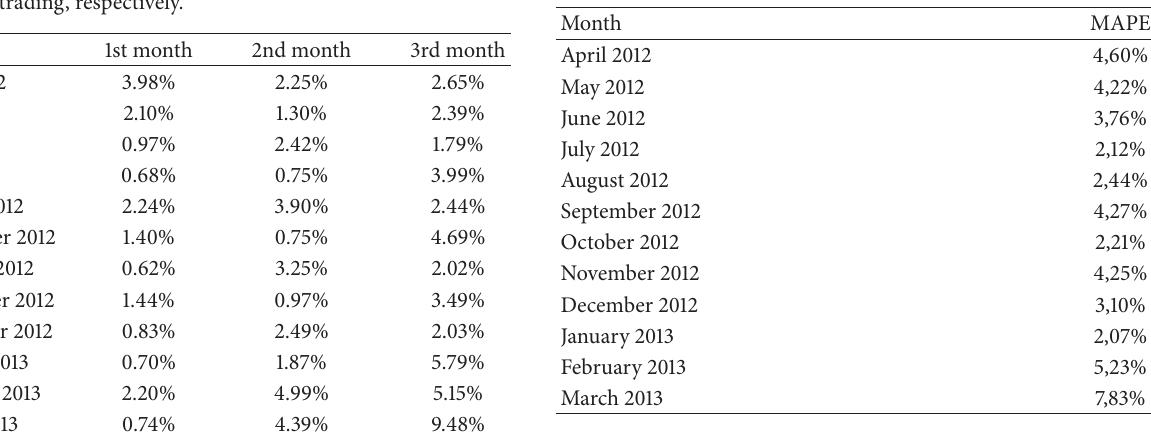
Table6:Inthefirstcolumn,wehavethemonthsofelectricitysupply of the peak contracts considered, while in the second column we have the mean absolute percentage errors obtained in the long-term forecasts of the contracts value using a geometric Brownian motion.